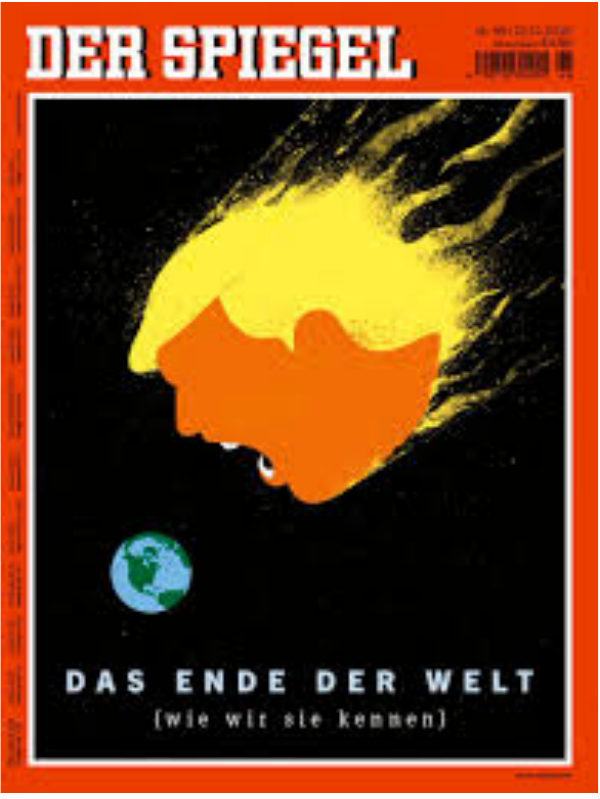
DER SPIEGEL DEPICTING TRUMP AS AN ASTEROID HEADING FOR EARTH COURTESY OF DER